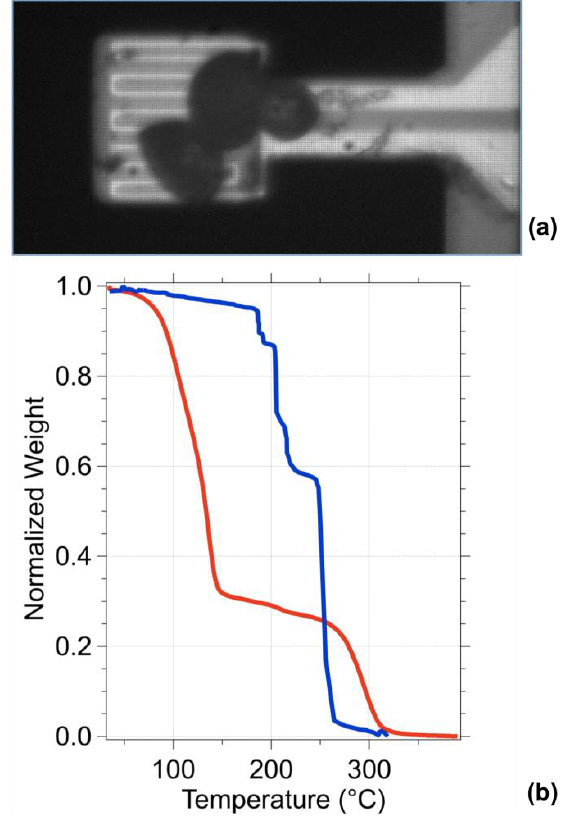
Figure 7. Microcapsule loaded cantilever. ( a ) Loaded sensor image. The picture has been taken with a CCD camera and an optical microscope. The dark-grey circles on the cantilever free end are three microcapsules presented in the solution; ( b ) Comparison between temperature analysis data measured using a commercial TGA (red) and cantilever-based TGA